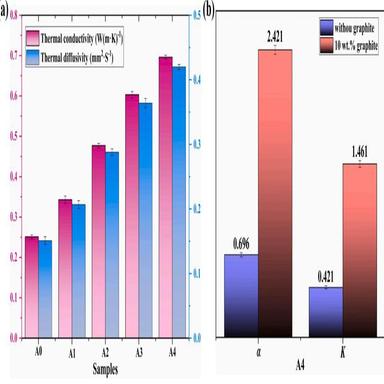
(a) Thermal conductivity and thermal diffusivity of CPCMs at 25 ◦C and (b) the comparison of ss-CPCM with and without the addition of graphite.